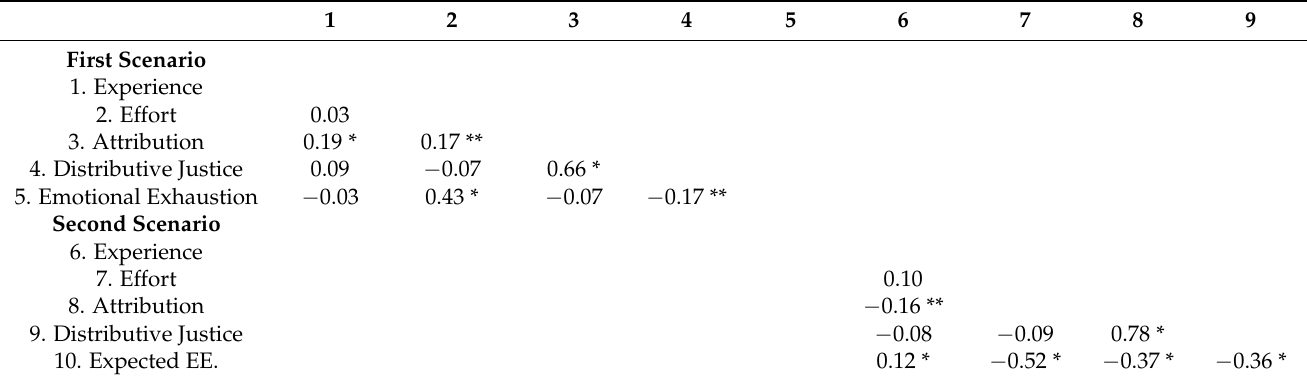
Table 2. Bivariate correlations between the study variables for presentation of the first and second scenario.